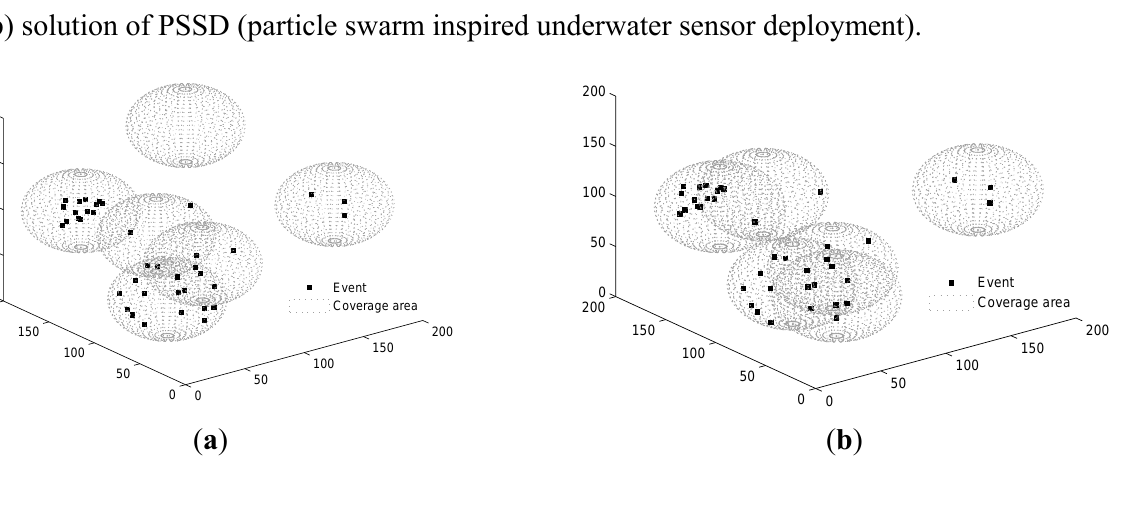
Figure 4. Events randomly distributed. ( a ) solution of SOM (self organizing